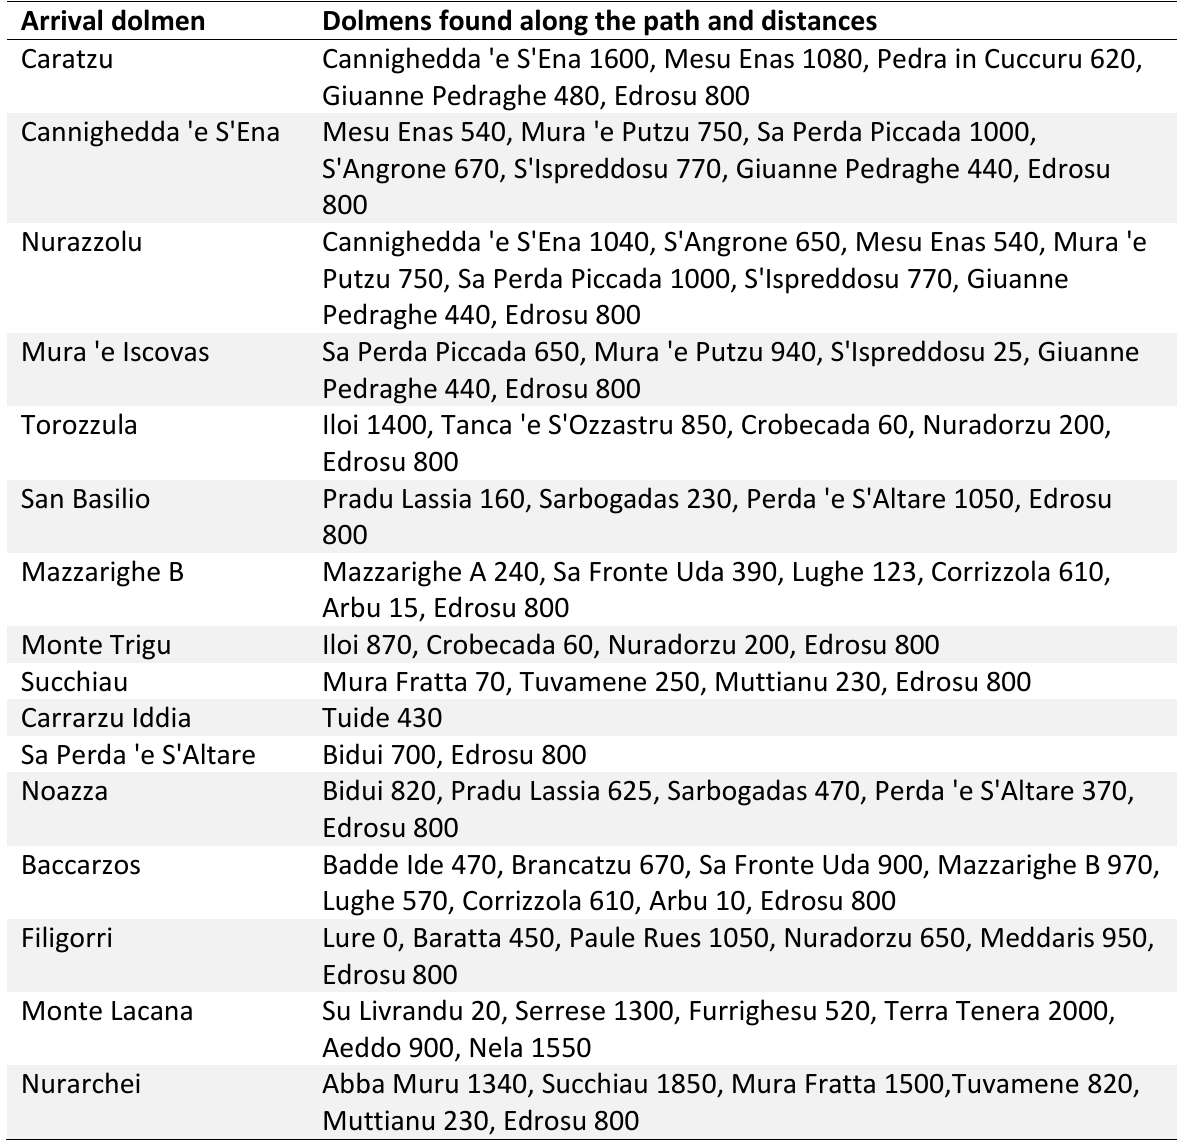
Table 2. Least-Cost Path Analysis from the sample area towards dolmen located at lower altitudes. (Distances in metres; accurate to the nearest round